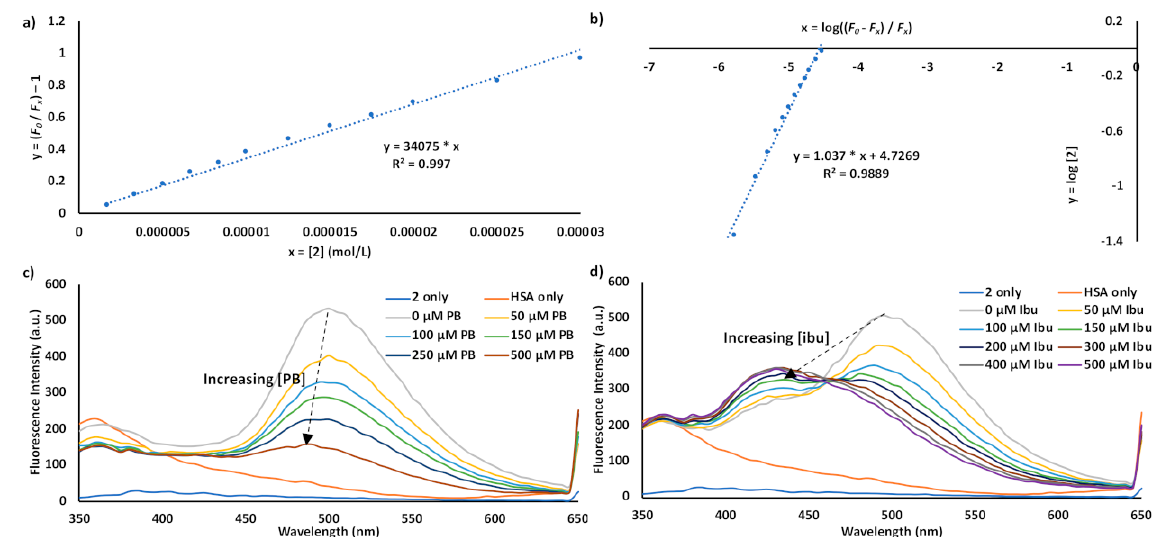
Figure 7. ( a ) Stern–Volmer plot for the addition of 2 into 5 µ M HSA in deionized water. F 0 , F x = fluorescence intensity at 360 nm (emission of HSA) in the absence ( F 0 ) and presence ( F x ) of quencher 2 . ( b ) Double logarithm plot. ( c , d ) Displacement studies involving plots of the fluorescence emission intensity of 10 µ M aqueous solutions of 2 containing 20 µ M HSA recorded upon addition of phenylbutazone (PB) and ibuprofen (Ibu), respectively. Experiments were conducted with excitation at 290 nm for ( a , b ) and excitation at 330 nm for ( c , d ); excitation and emission slit widths were 5 nm, respectively, in all